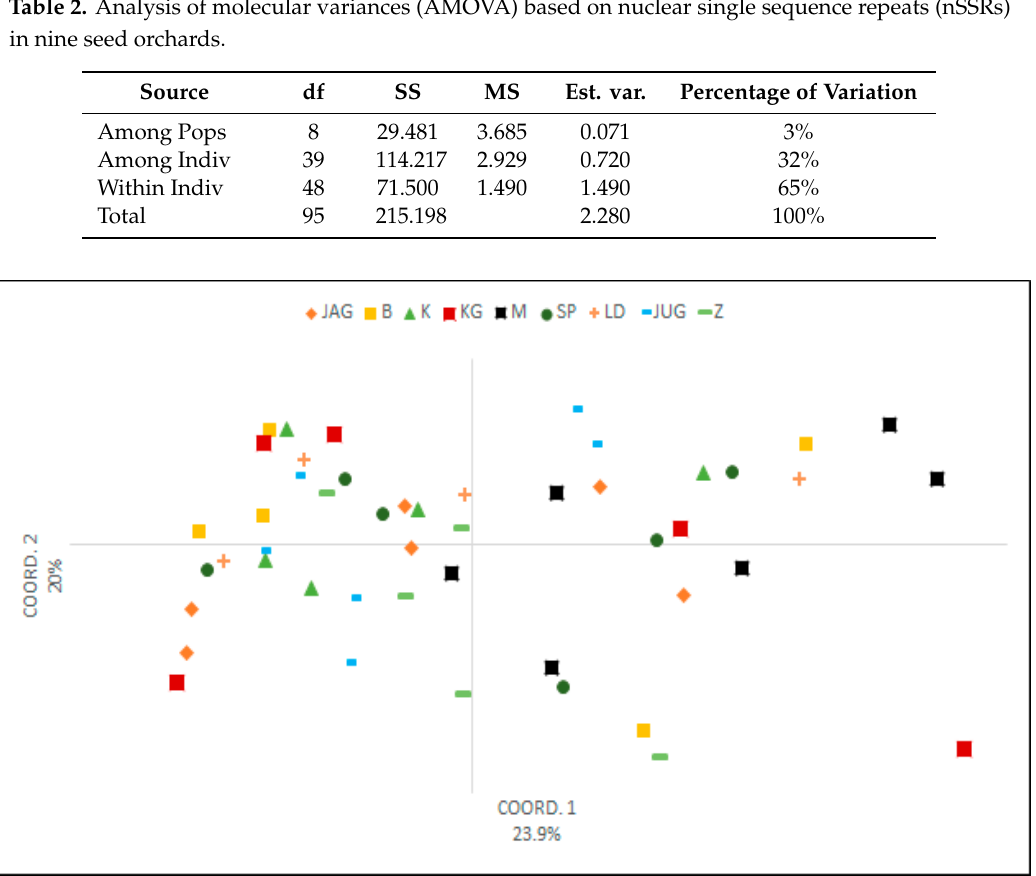
Figure 2. PCA on nSSRs conducted for 48 trees from nine seed orchards.